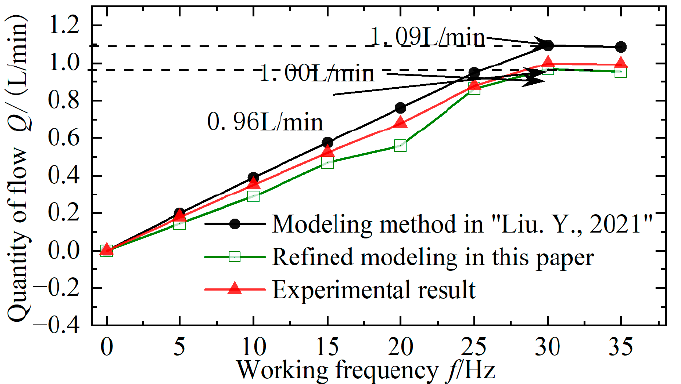
Figure 9. Curves of flow with different frequencies.